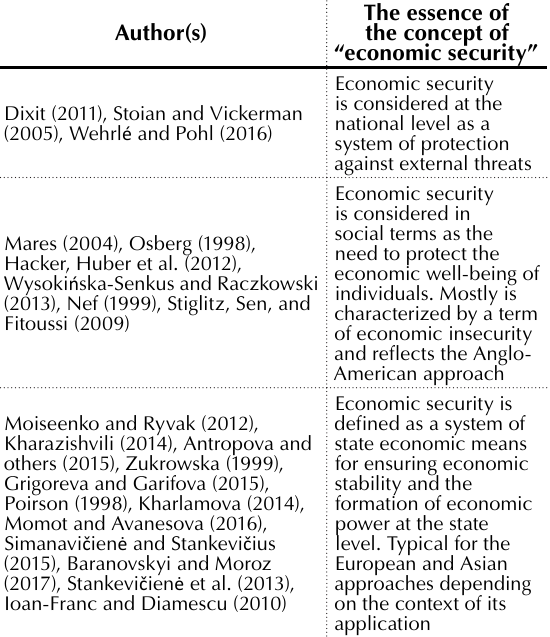
Table 1. Approaches to understanding